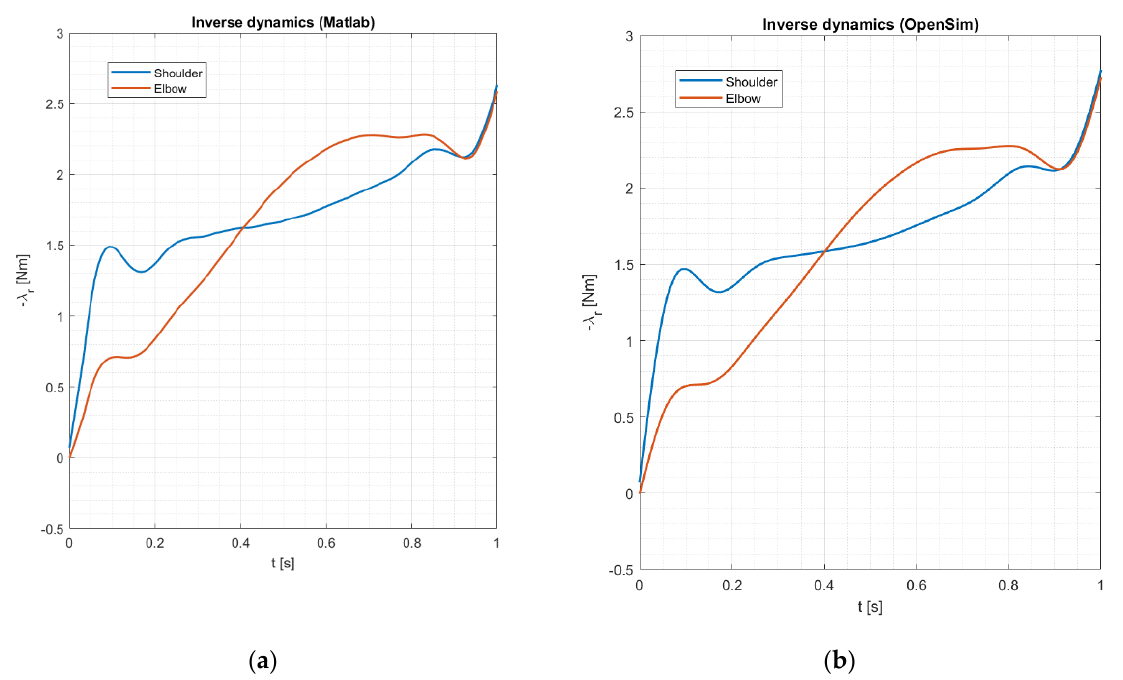
Figure 13. Inverse dynamics comparison: ( a ) Matlab and ( b ) OpenSim.